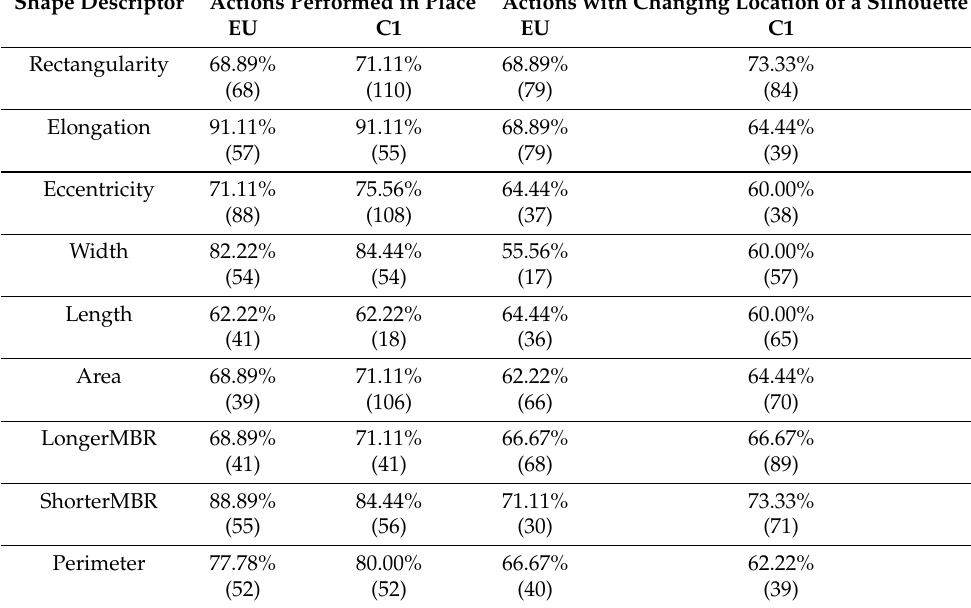
Table 1. Results for the experiments using the ‘lower-occlusion’ database. Correct classification rates are given for coarsely classified actions, nine shape descriptors based on the Minimum Bounding Rectangle and two matching measures (EU—distance, C1—correlation). The number of the DFT coefficients is given in brackets.